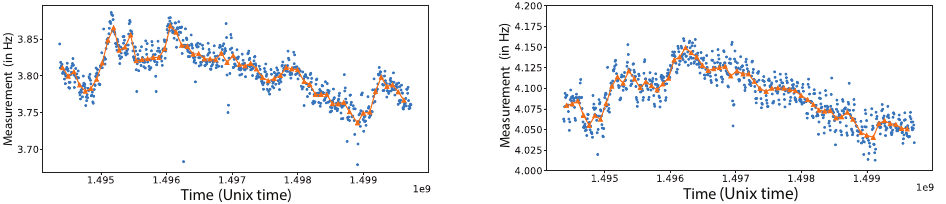
Figure 6. The estimated values for the first (right) and the second (left) eigenmode using for the current quantity a time window of 2 h (blue dots) and 24 h (orange triangles). The reference quantity is the same for both plots and is computed using the first 8 days of